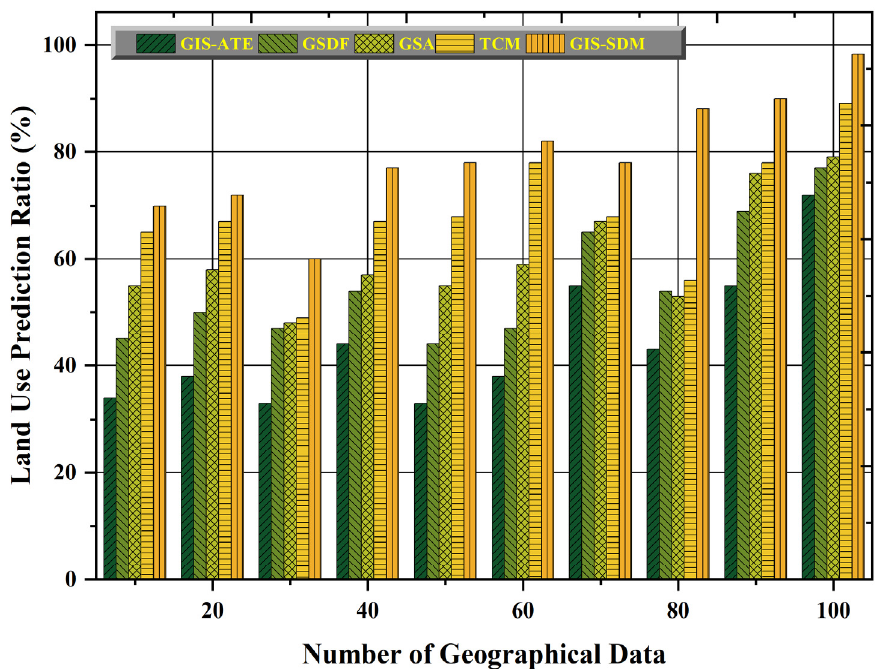
Figure 6. Land use prediction ratio.